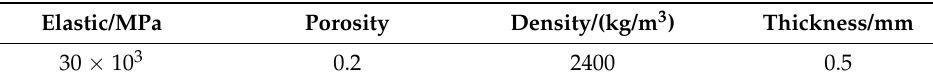
Table 2. Mechanical parameters of the panel.